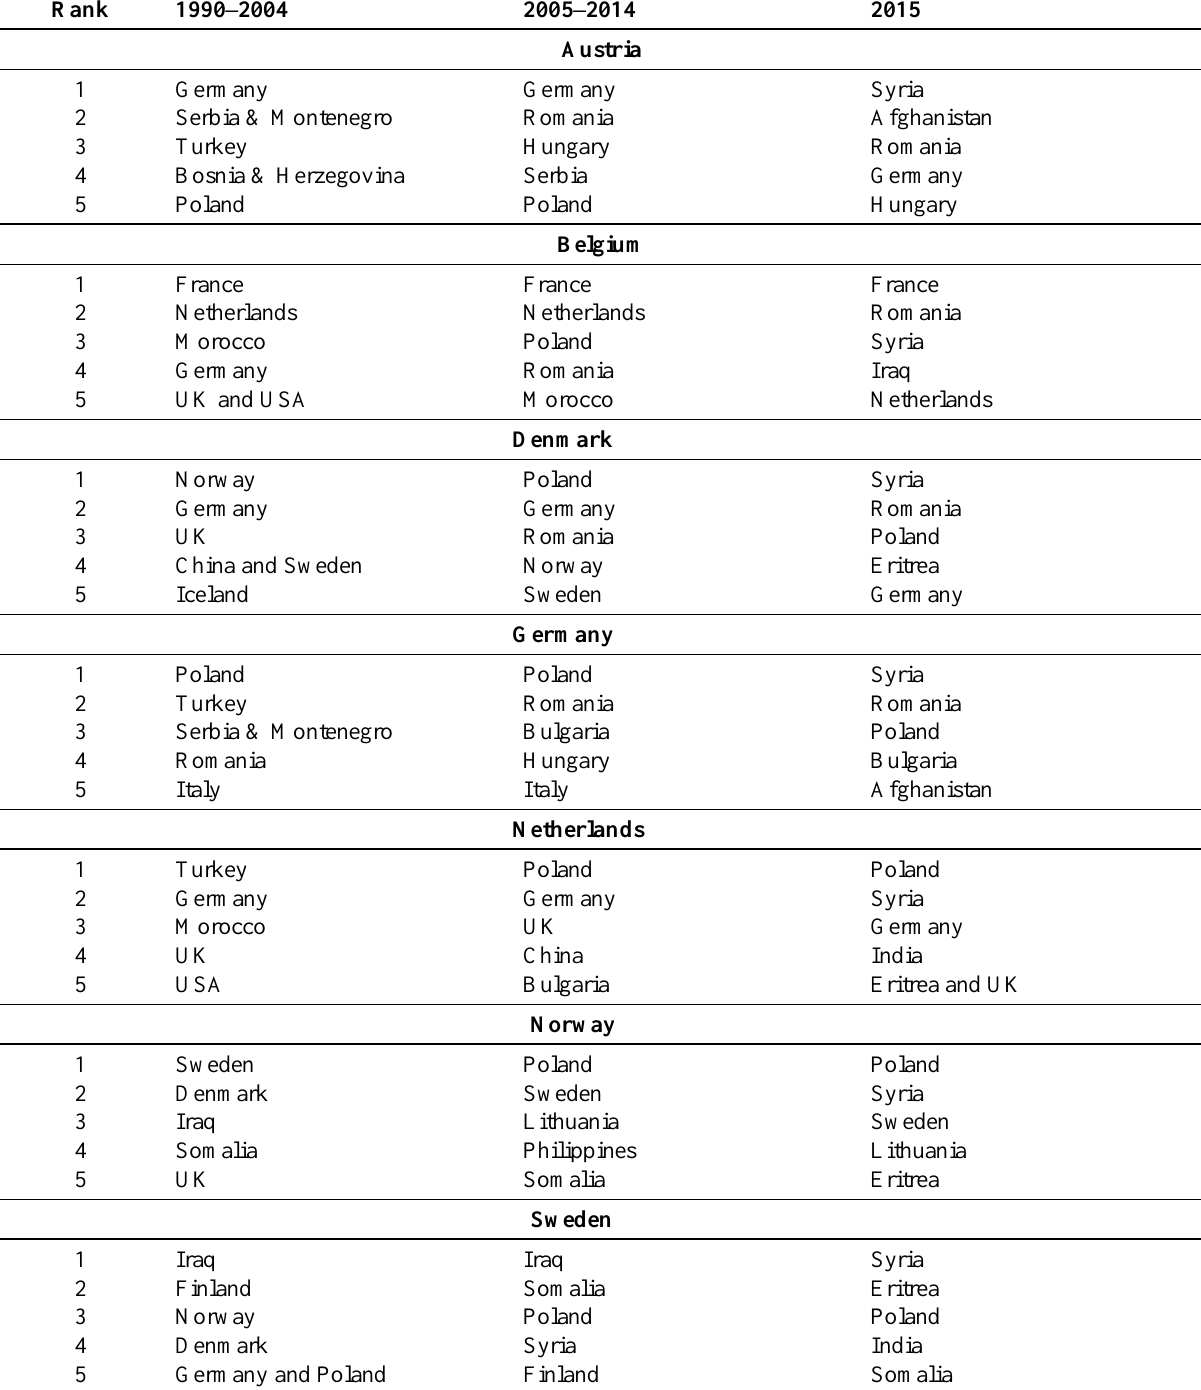
Table 2. Top five sending countries in selected European Economic Area countries; 2015 compared with 1990–2004 and